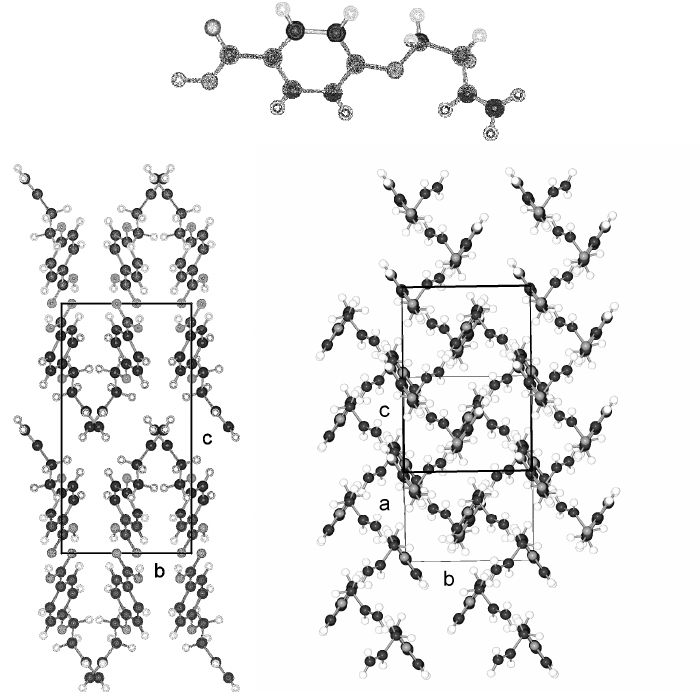
Figure 17. Representation of the conformation and the packing arrangement of 4-(but-3-enoxy)benzoic acid (BOBA), space group P2 and down the molecular